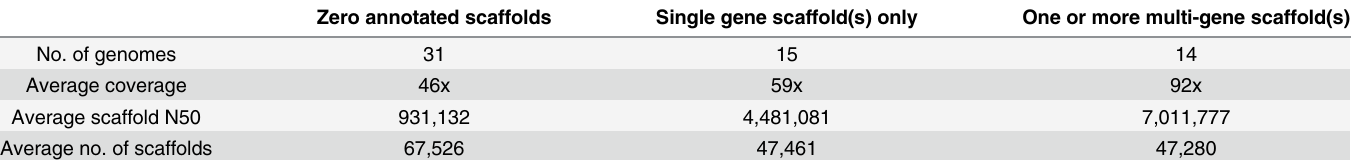
Table 2. Avian genome quality and its relationship to the annotation and assembly of the foxp3 gene neighbourhood.